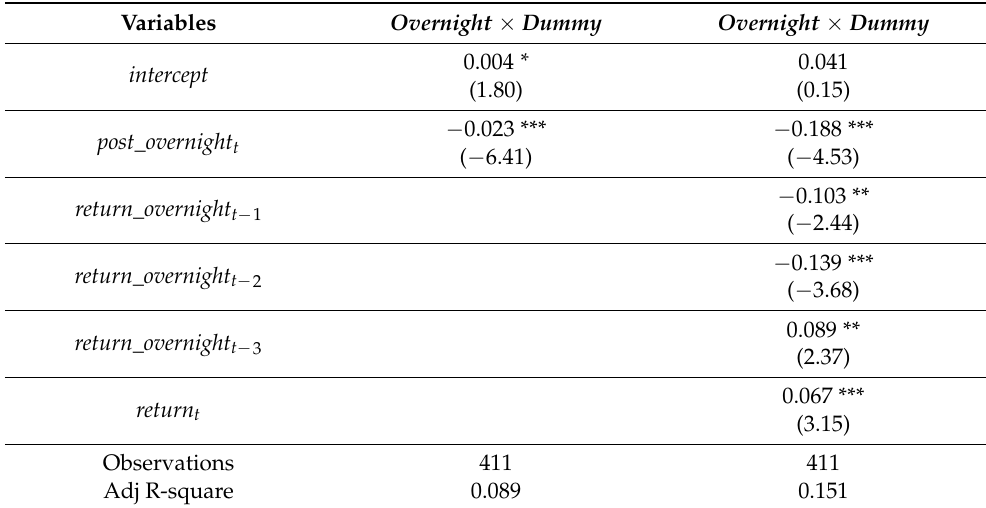
Table 7. Regression of overnight return against investor attention. The table presents the results of the regression 1 of negative overnight return on posts. The variable dummy is an indicator of negative daytime returns ( dummy = 1 for negative daytime returns, otherwise 0). The lagged returns control for existing information in the market.